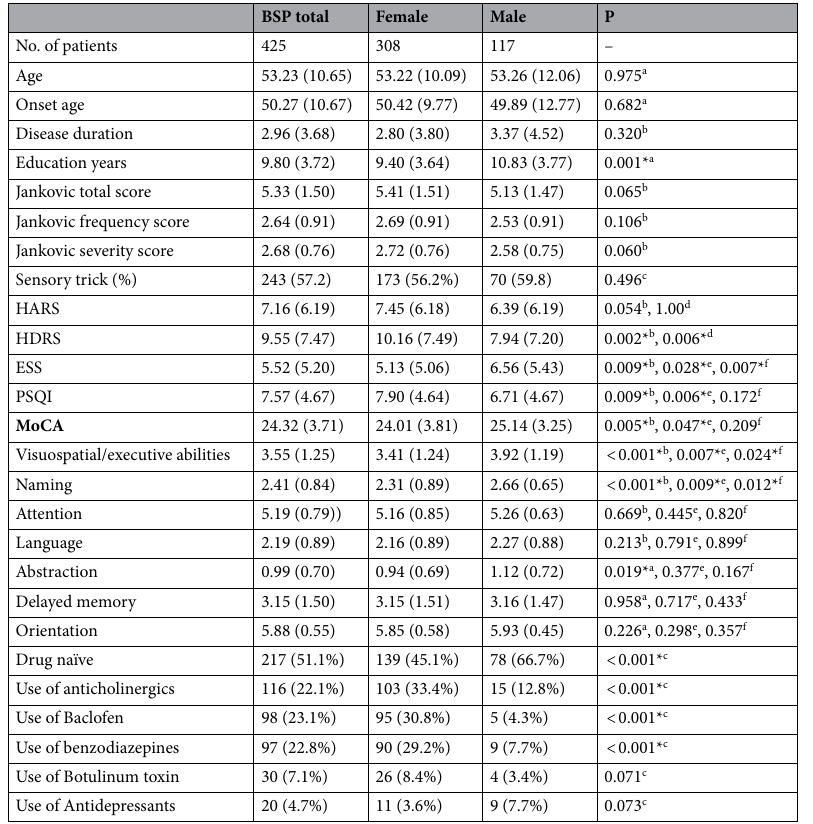
Table 1. Demographic and clinical features of 425 patients with blepharospasm. HARS, Hamilton Rating Scale for Anxiety; HDRS, Hamilton Rating Scale for Depression; ESS, Epworth Sleepiness Scale; PSQI, Pittsburg Sleep Quality Index; MoCA, Montreal Cognitive Assessment. *Significant difference. a Student t-test; b Mann- Whitney U test; c Chi-squared exact test; d ANCOVA with age, education years, disease duration, Jankovic total score, and use of antidepression drug as covariates; e ANCOVA with age, education years, disease duration, Jankovic total score, and use of benzodiazepines, and use of anticholinergics as covariates; f ANCOVA with age, education years, disease duration, Jankovic total score, use of benzodiazepines, use of anticholinergics, HDRS score and HARS score as